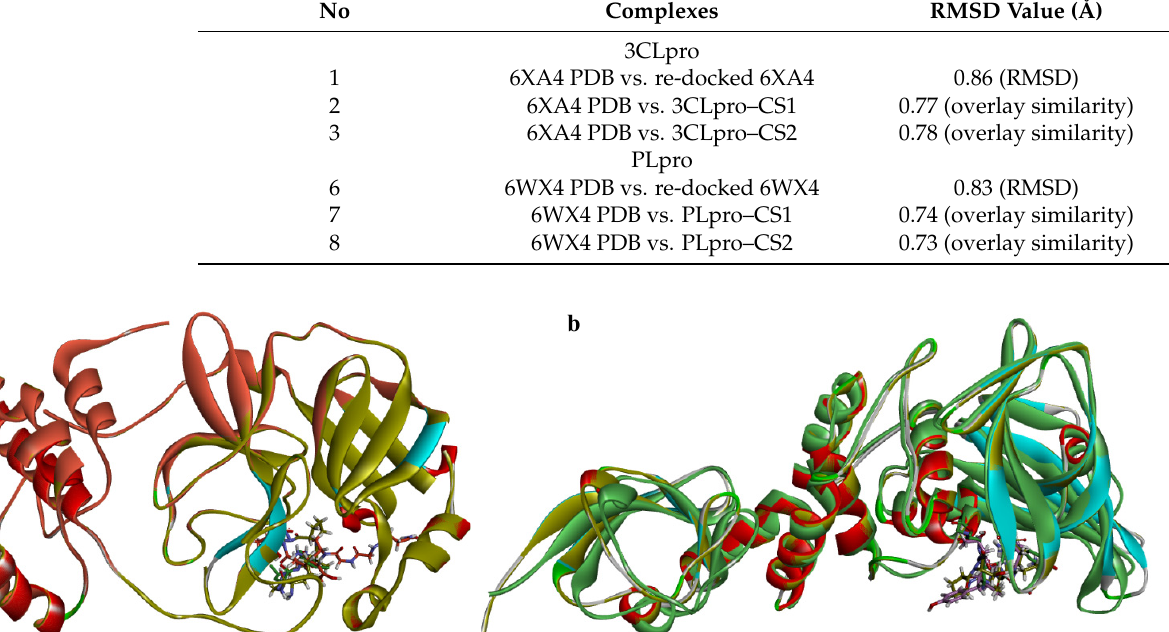
Figure 2. ( a ) Three-dimensional representation of the superimposed SARS-CoV-2 3CLpro (6XA4, blue) from PDB, 3CLpro–CS1(light brown) and 3CLpro–CS2 (red). ( b ) Superimposed SARS-CoV-2 PLpro (6WX4, blue) from PDB, PLpro–CS1(light brown) and PLpro–CS2 (red) to validate docking binding at the active site of the proteases.